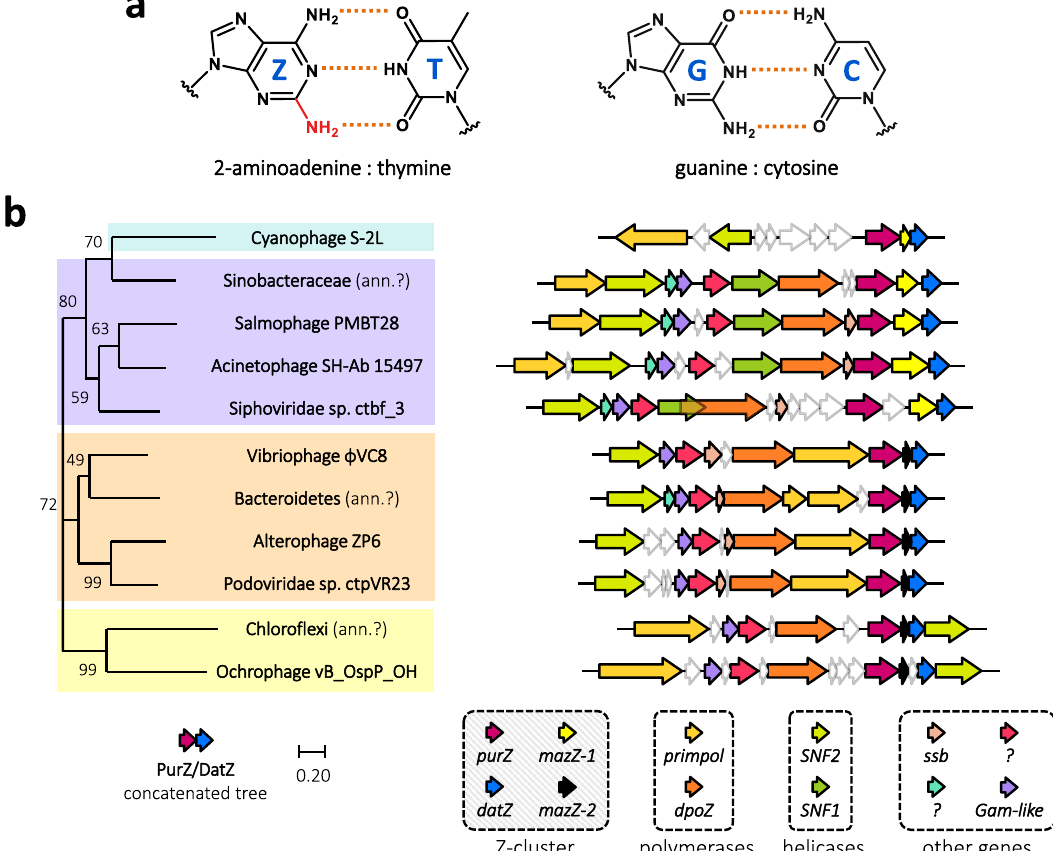
Fig. 1 ZTGC-DNA and conservation of the Z-cluster in Siphoviridae and Podoviridae phages. a Chemical structure of Z:T and G:C base pairs constituting S-2L ’ s ZTGC-DNA. b Genomic map of most important replication genes in all phages with close purZ and datZ homologues, and their phylogeny.